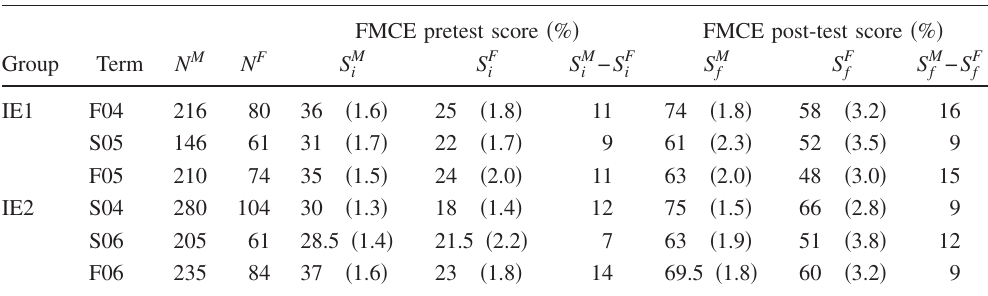
TABLE II. FMCE (cid:1) Ref. 2 (cid:2) data for the introductory calculus-based physics course at CU; N M (cid:1) F (cid:2) is the number of males (cid:1) females (cid:2) for whom there are matching FMCE pre- and post-test data; S iM (cid:1) F (cid:2) is the average pretest score for males (cid:1) females (cid:2) (cid:3) using Thornton’s scoring rubric (cid:1) Ref. 10 (cid:2)(cid:4) ; and S f is the average post-test score. The numbers in parentheses represent the standard error of the mean, not the standard deviation. S M − S F equals the gender gap (cid:1) Ref. 12 (cid:2)